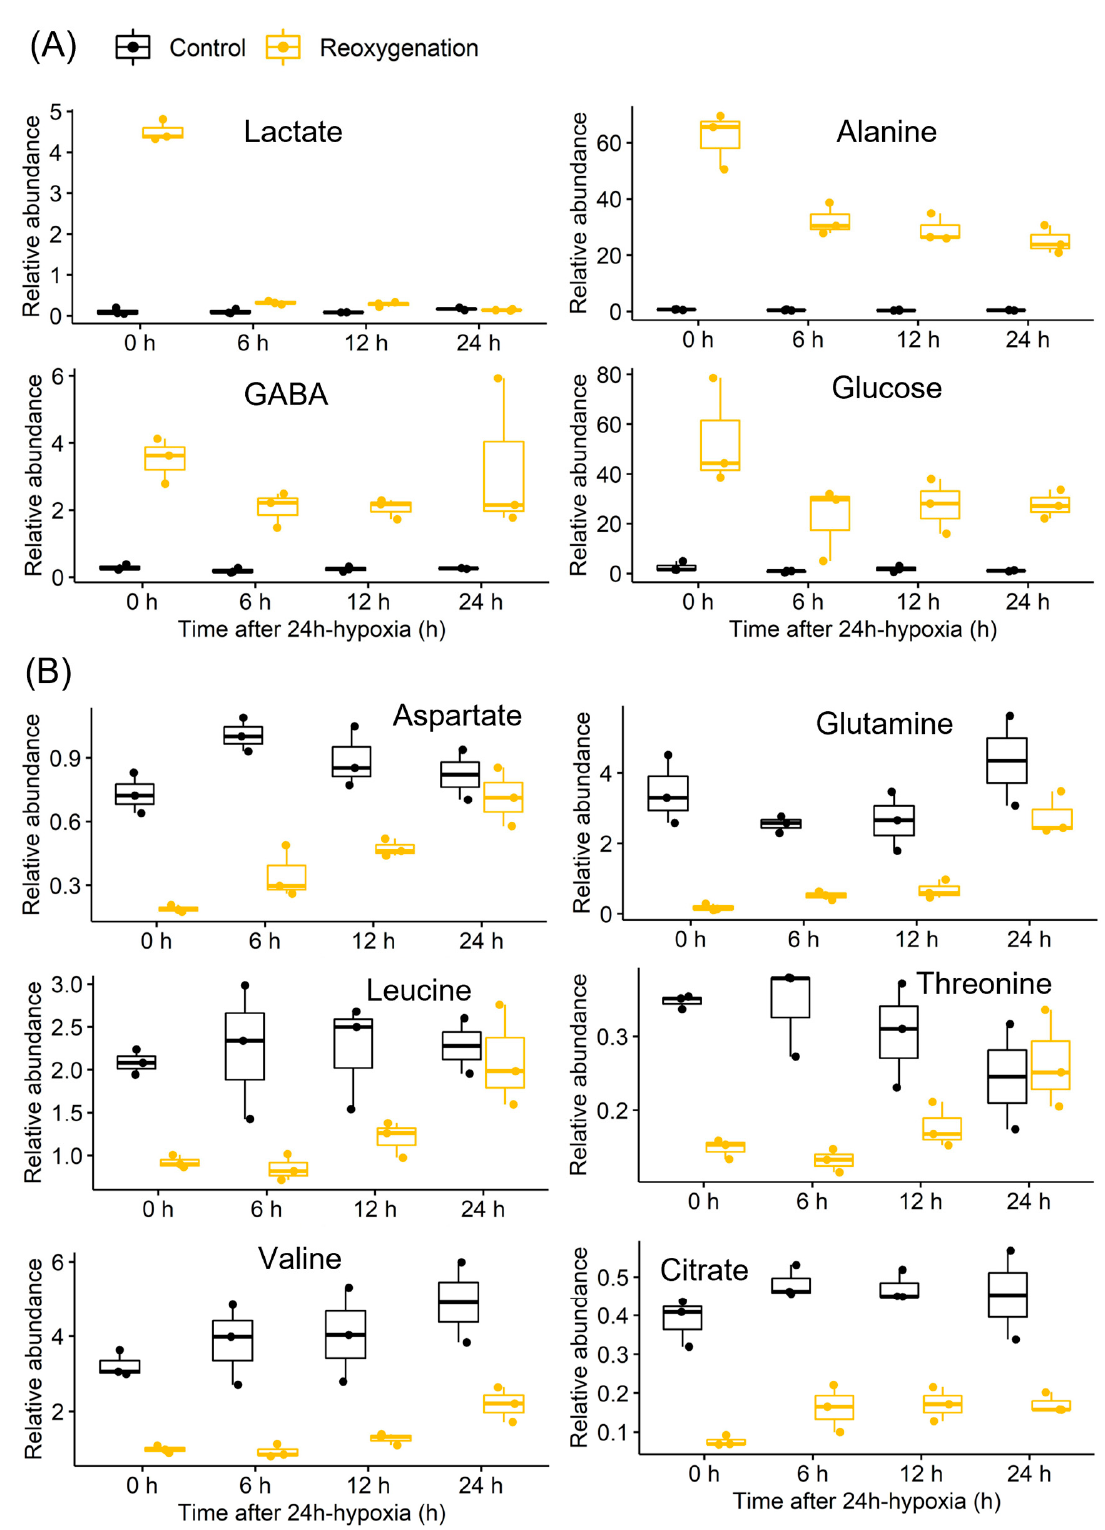
Figure 5. Hypoxia-induced metabolic changes returned during oxygenation. ( A ) Lactate, alanine, GABA, and glucose increased during hypoxia but decreased during reoxygenation. ( B ) Aspartate, glutamine, leucine, threonine, valine, and citrate decreased during hypoxia but increased during reoxygenation. Data are presented as box plots (center line at the median, upper bound at 75th percentile, lower bound at 25th percentile) with whiskers extended to the extreme data points ( n = 3).